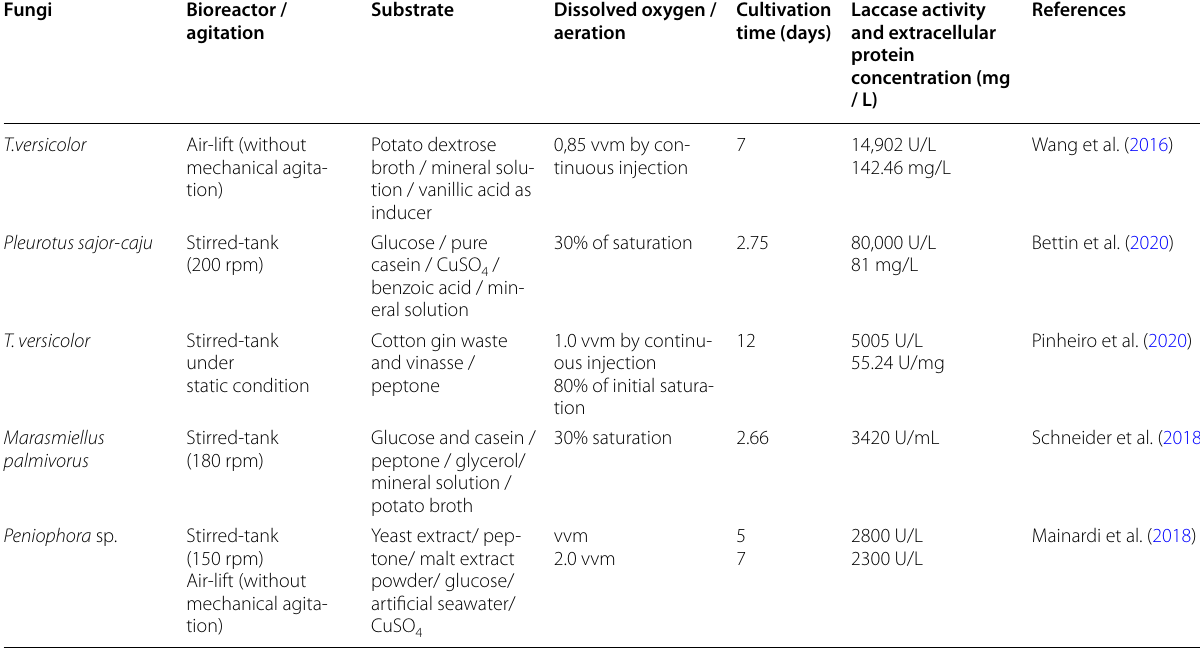
Table 1 Fungal laccase production in bioreactors: cultivation conditions and enzymatic activity